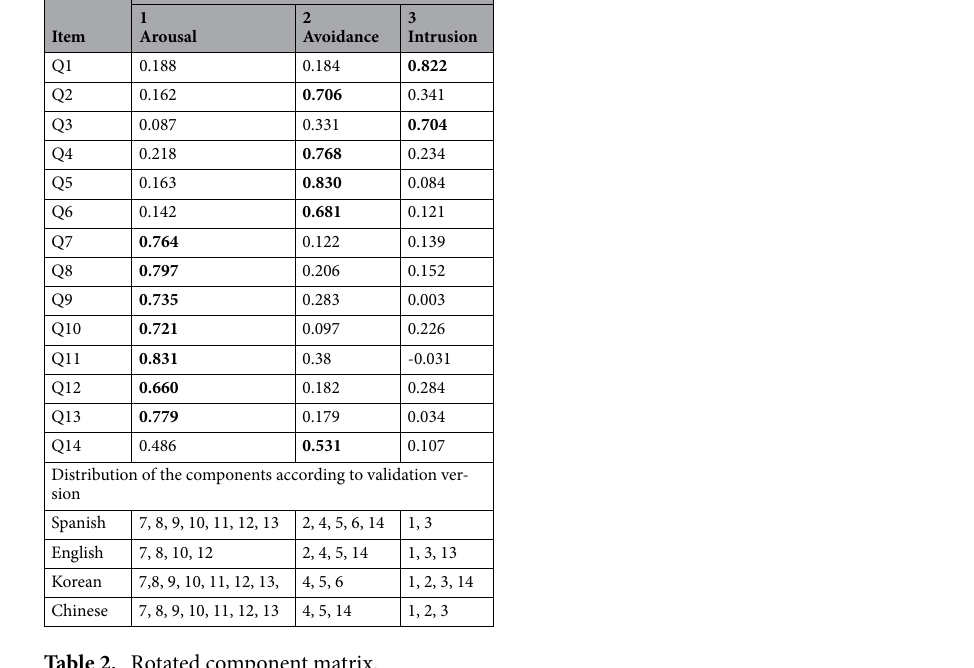
Table 2. Rotated component matrix.